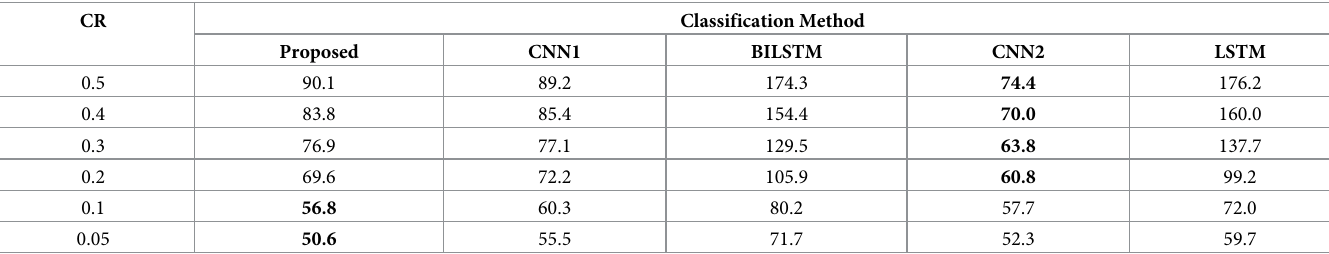
Table 6. The time (s) spent in parameter training for each classification network.